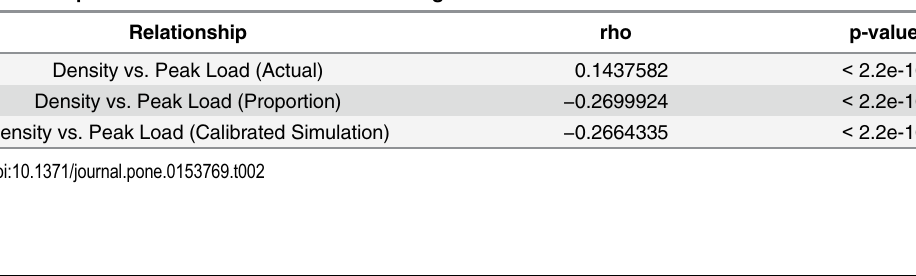
evolution. Fig 6 represents the default plot of GAM results. Solid lines represent predicted val- ues of peak load as a function of density. Small vertical lines on the x axis show the location of the sample points. The gray area is interpreted as the standard errors of the estimates provided